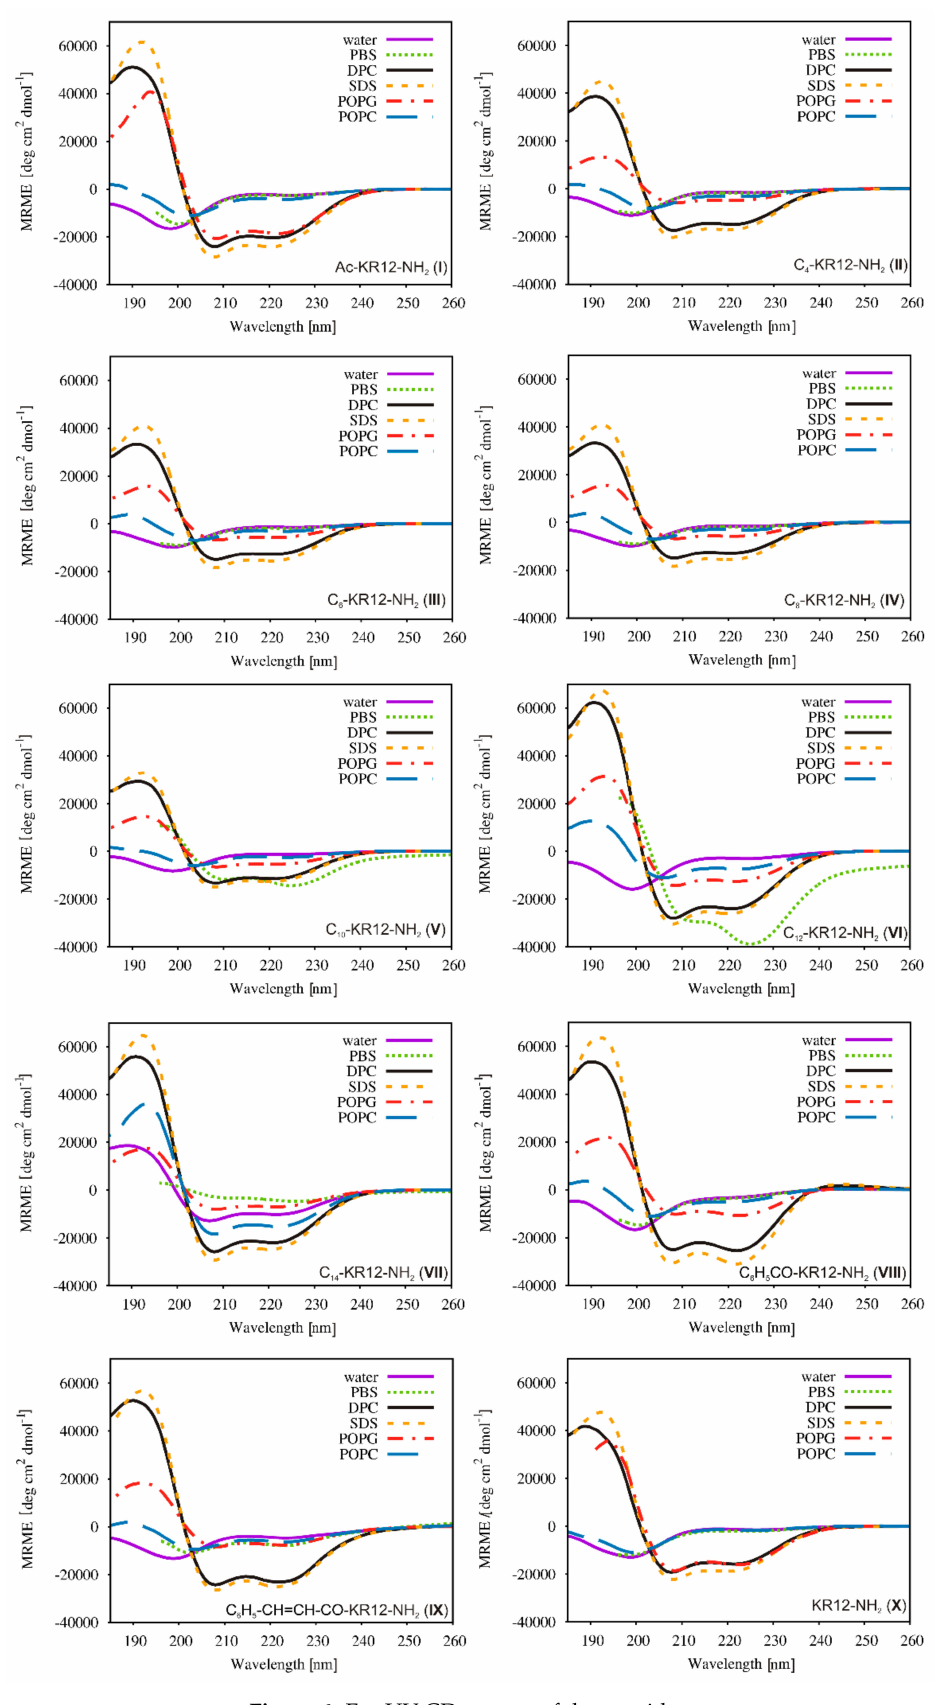
Figure 6. Far-UV CD spectra of the